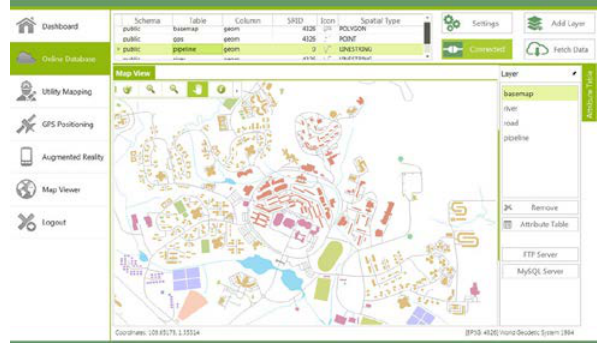
Figure 4. The mobile mapping application main interface shows multiple layers being mapped collaboratively offline.